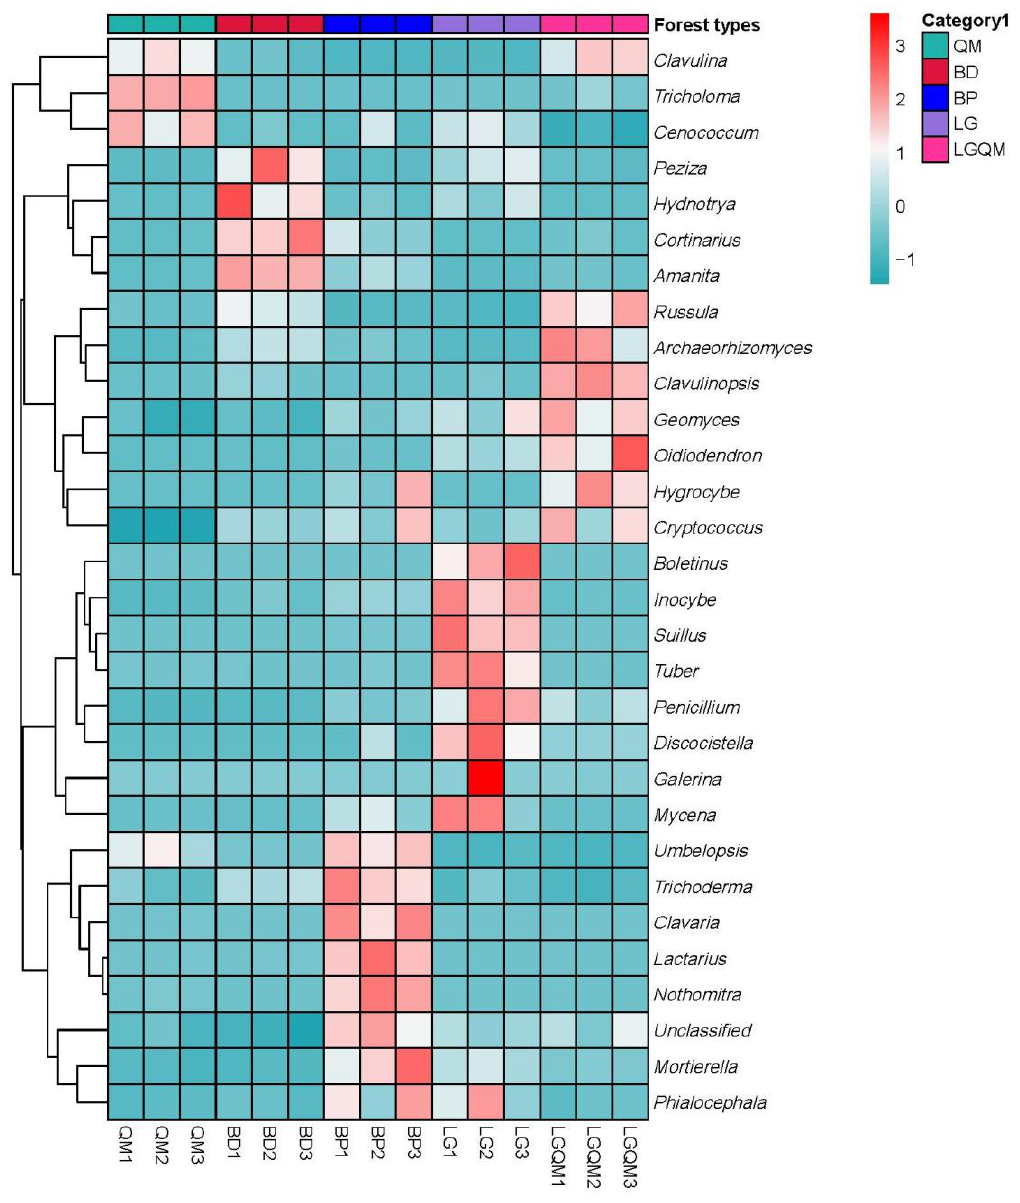
Figure 7. Heatmap and hierarchical clustering of the relative abundances of the top 30 genera de- tected in the soil fungal communities. The color gradient (red, white, blue) represents the relative abundance of the soil fungi from high to low in the different forest types. BD1–BD3, Betula dahurica ;